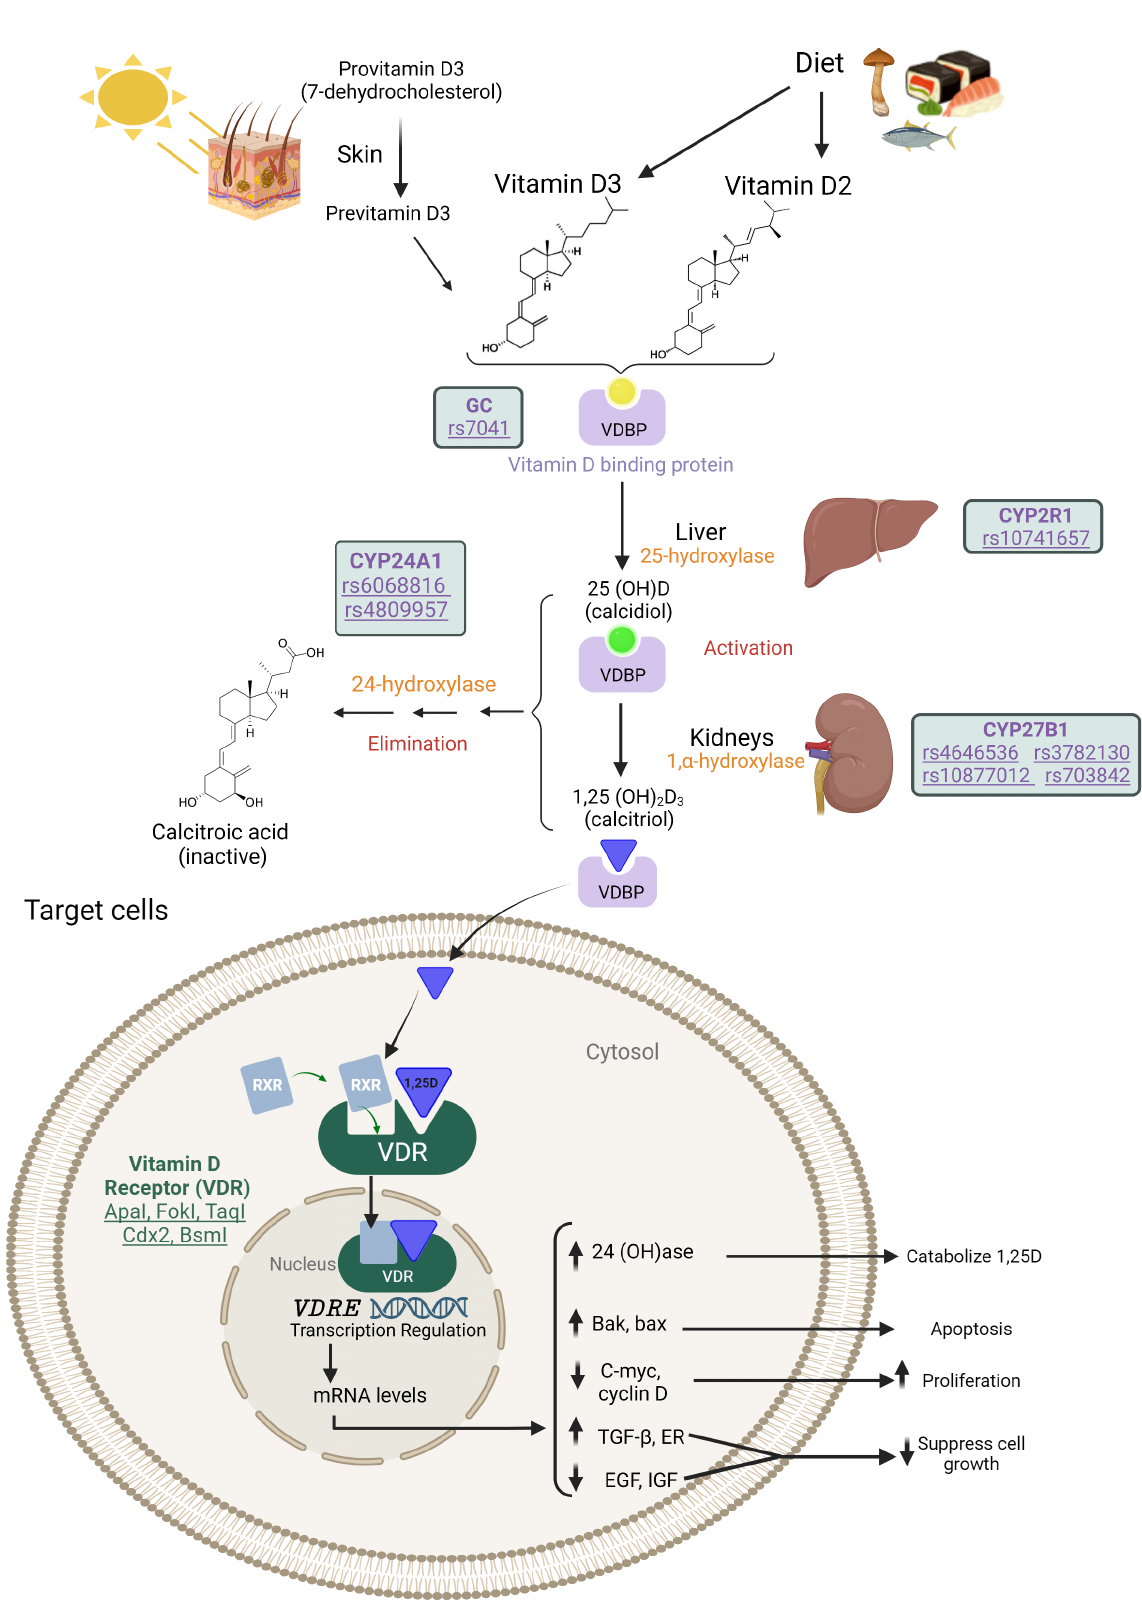
Figure 1. Metabolic pathway of vitamin D.